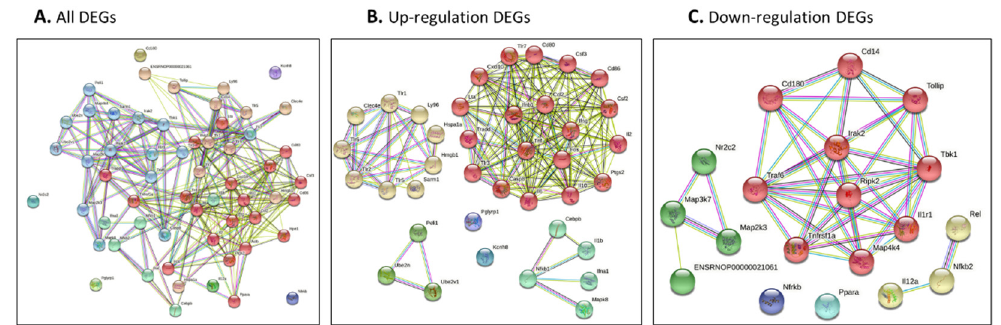
Figure 4. ( A – C ) Protein–protein interaction network of all identified genes for burn injury using String-DB. Genes were identified using our network approach. Colored nodes indicate first shell interactions. Edges represent protein–protein associations. Blue indicates that the information is from curated databases, and pink indicates that it is experimentally determined; green is the gene neighborhood; dark blue represents gene co-occurrence; yellow represents information gathered from text mining; black represents co-expression; and light blue represents protein homology. Proteins with no interactions are not included in the figure for clarity. ( A ) all DEGs; ( B ) up-regulated DEGs; and ( C ) down-regulated DEGs. ( A , B ) Functional interaction network based on the STRING database and Gene Ontology classification. Different colors represent different clusters, and the details are described in the text.